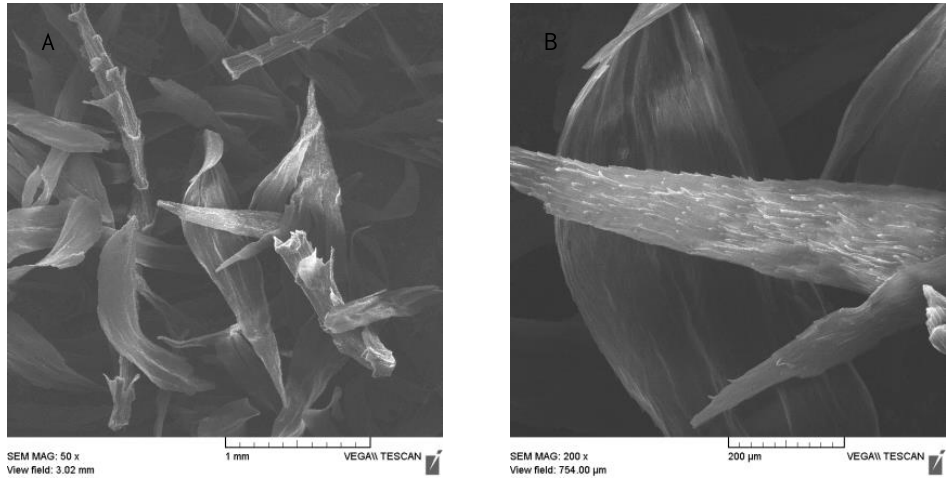
Figure 1. SEM images of native biomass of moss R. squarrosus ( A ) magnification 50 × , ( B ) 200 × .